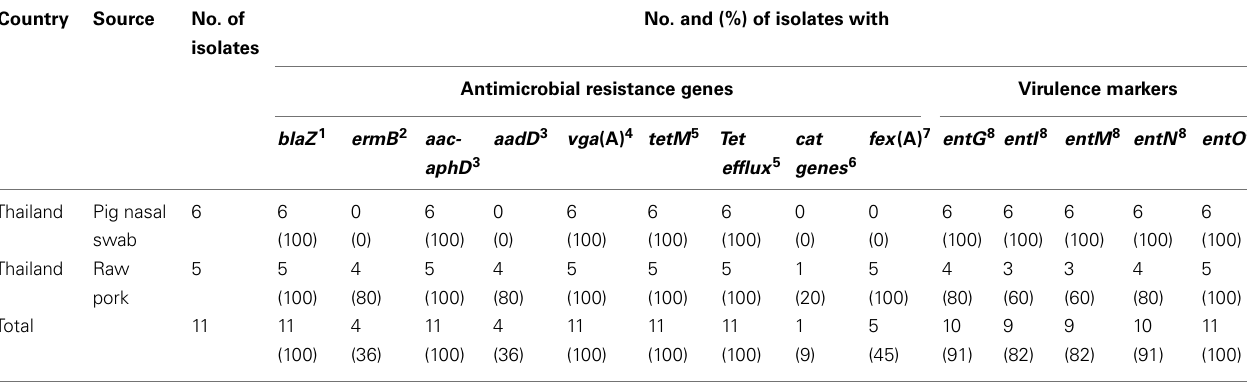
Table 1 | Distribution of antimicrobial and virulence factors Staphylococcus aureus isolates originating from pork and pigs inThailand. Country Source No. of isolates